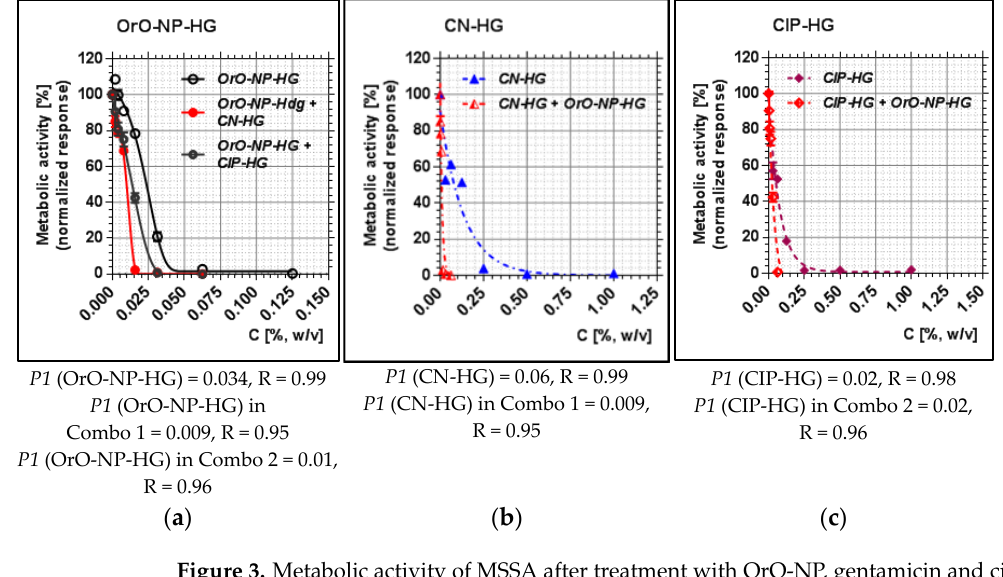
Figure 3. Metabolic activity of MSSA after treatment with OrO-NP, gentamicin and ciprofloxacin and synergistic combinations in hydrogels: ( a ) OrO-NP-HG, single application and in combinations with CN-HG or CIP-HG; ( b ) CN-HG, single application and in combination with OrO-NP-HG; ( c ) CIP-HG, single application and in combination with OrO-NP-HG. Legend: ( a ) OrO-NP-HG; ( b ) CN-HG; ( c ) CIP-HG; P1 — inhibitory constant, which may be interpreted as the dose achieving 50% inhibition; decrease in P1 for CIP after the addition of OrO-NP-HG. R—correlation coefficient; OrO—oregano oil; NP—nanoparticles; HG—hydrogel; CN—gentamicin; CIP—ciprofloxacin.